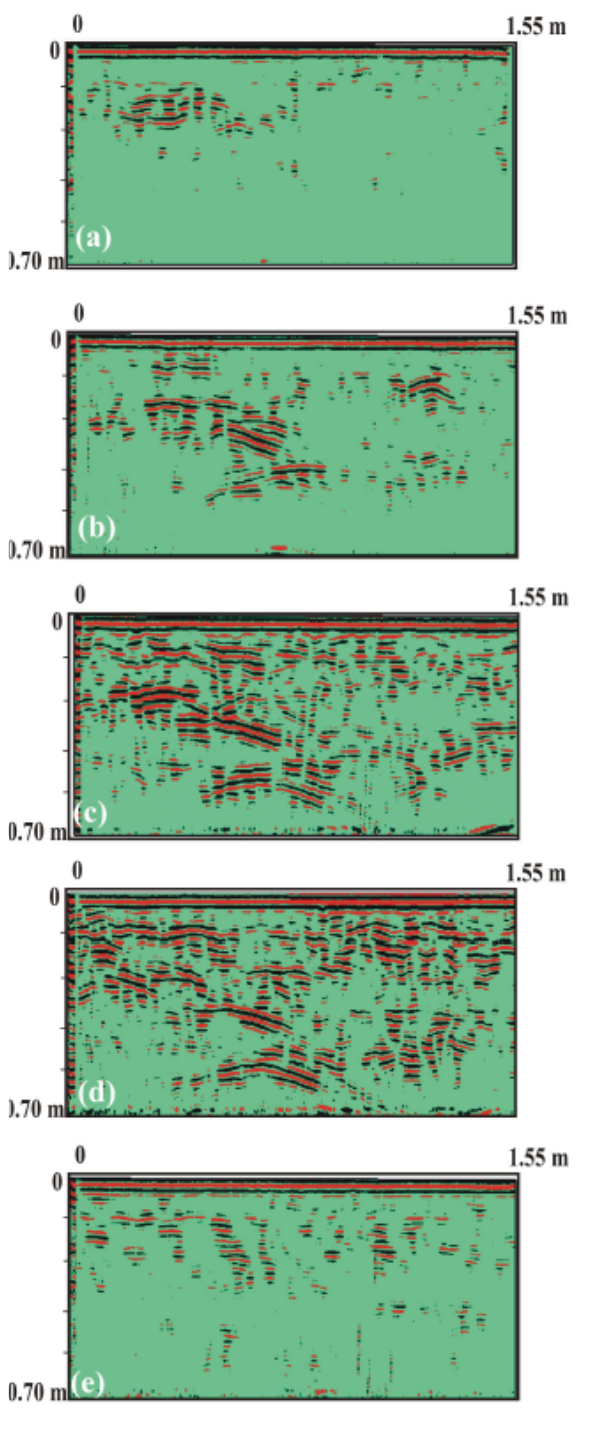
Fig. 8. The radargrams of (a) profile 1, (b) profile 2, (c) profile 3, (d) profile 4 and (e) profile 5 of the skirt part of the first woman statue with new amplitude-color approximation.